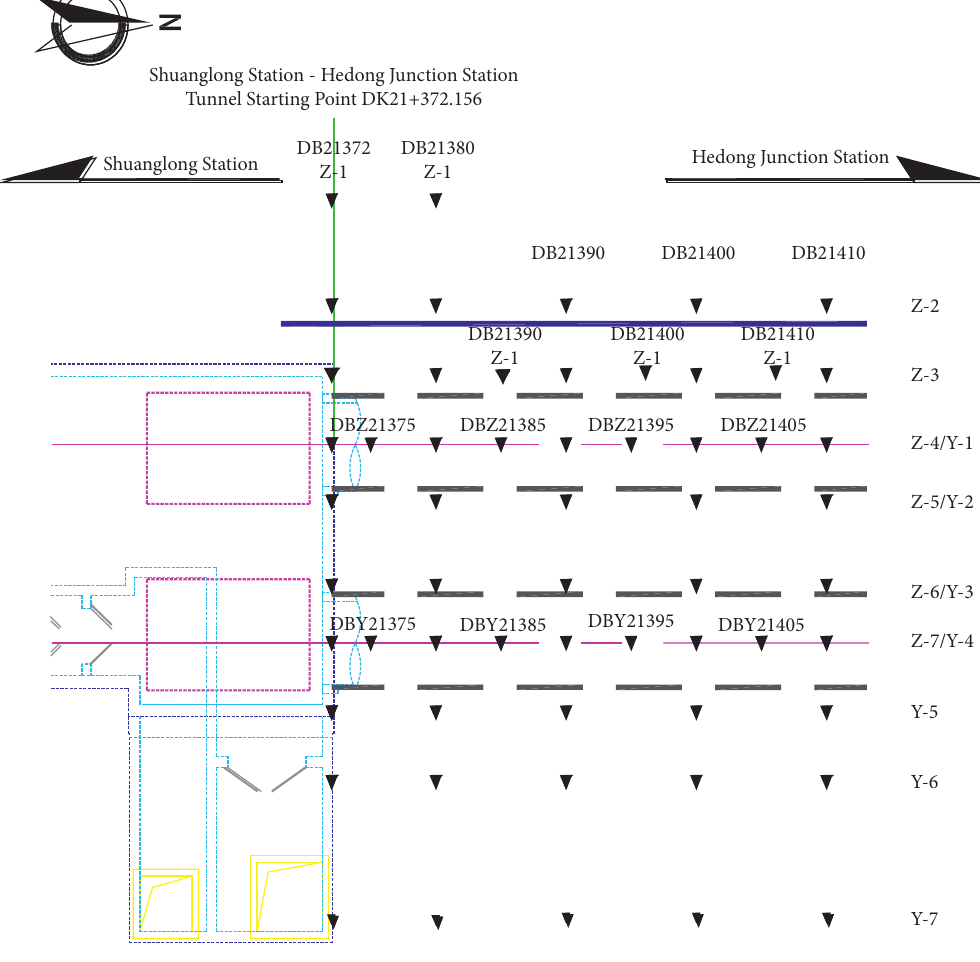
Figure 12: The location of partial monitoring points.